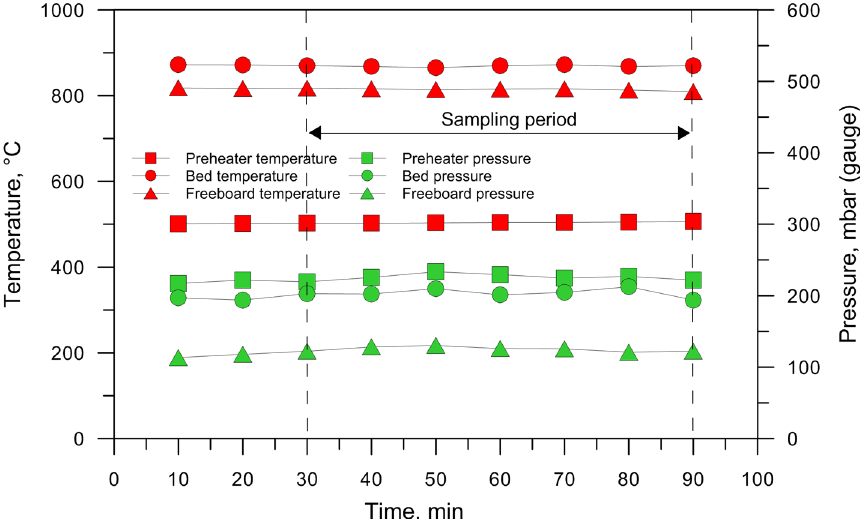
Figure 3. Temperature and pressure profiles obtained during wood gasification